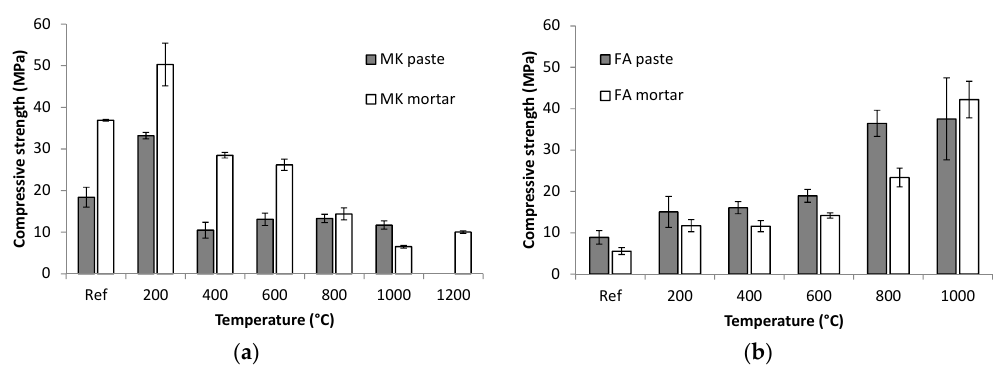
Figure 3. Residual compressive strengths of metakaolin ( a ) and fly ash ( b ) geopolymer pastes and mortars after exposure to high temperatures. Standard deviations are depicted as error bars.